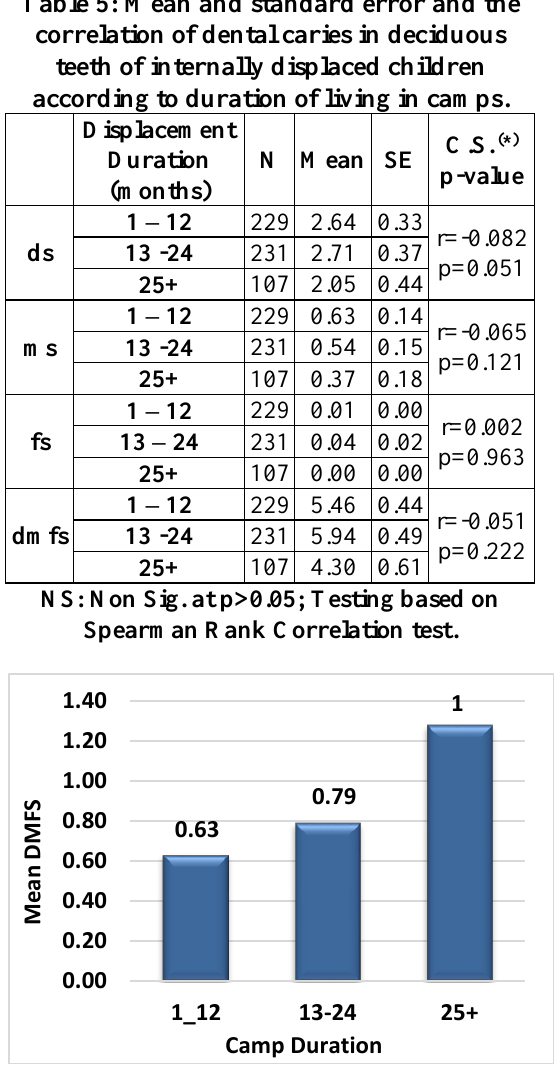
Figure 1: Mean dental caries in permanent teeth of internally displaced children according to duration of living in